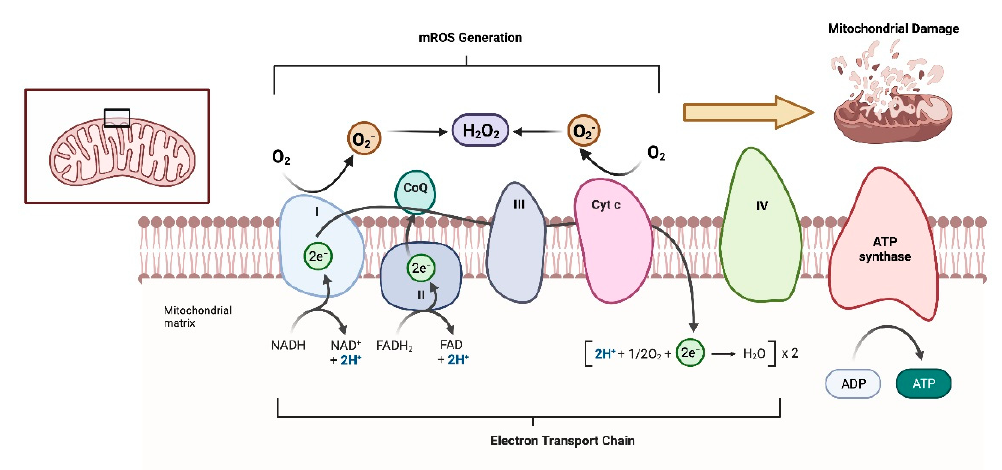
Figure 3. Energy metabolism and oxidative stress in granulosa cell